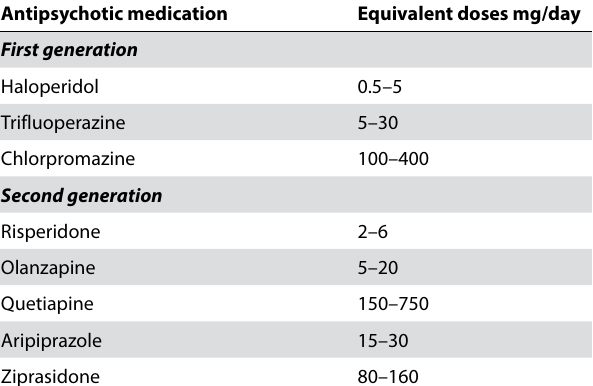
Table 4: Commonly prescribed antipsychotic